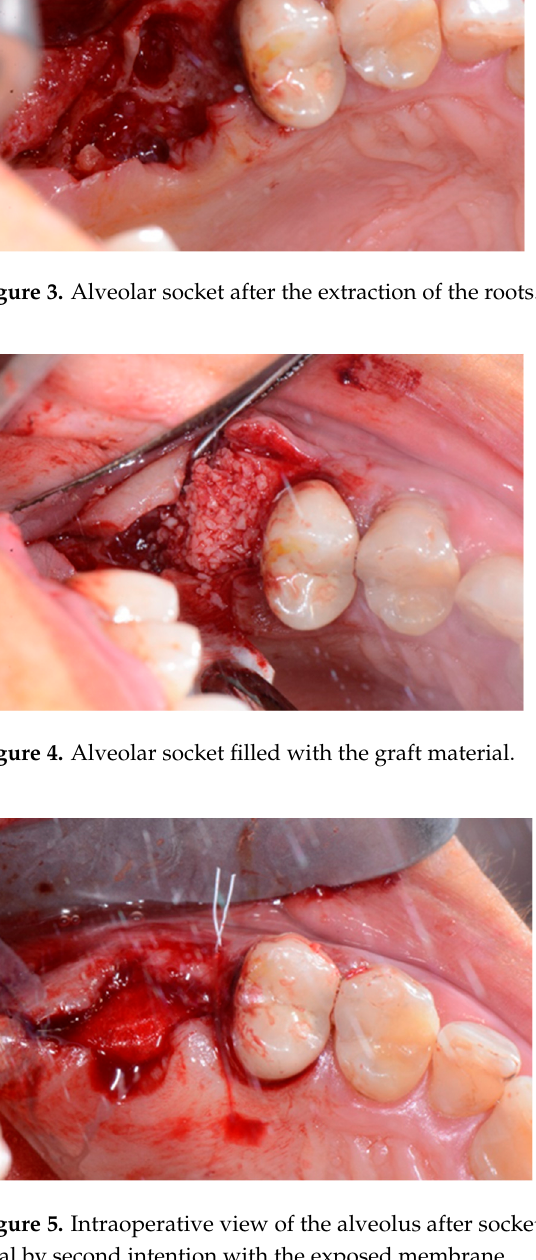
Figure 5. Intraoperative view of the alveolus after socket preservation. The preserved site is left to heal by second intention with the exposed membrane. heal by second intention with the exposed